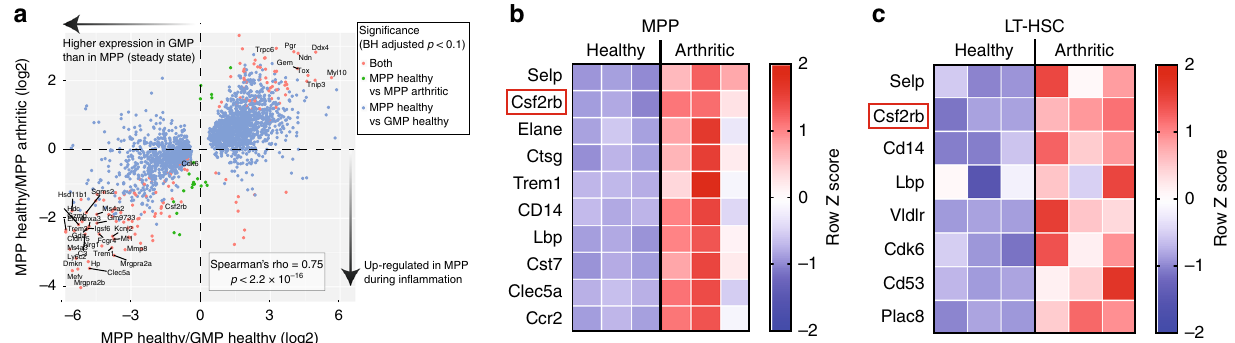
Fig. 2 HSC and MPP upregulate myelopoiesis associated genes in SpA. a – c In three separate experiments, mice ( n = 8 per group) were injected with curdlan (arthritic) or PBS (healthy) before culling after 5 weeks and LT-HSCs, ST-HSCs, MPPs, and GMPs were isolated by FACS for RNA sequencing. a Scatter plot comparing genes differentially expressed between GMPs and MPPs in healthy animals ( x -axis) with those differentially expressed in MPPs between healthy and spondyloarthritic animals ( y -axis). b , c Heat map showing expression of selected genes upregulated in MPPs ( b ) and LT-HSCs ( c ) with development of SpA. Each column represents independent groups of eight pooled